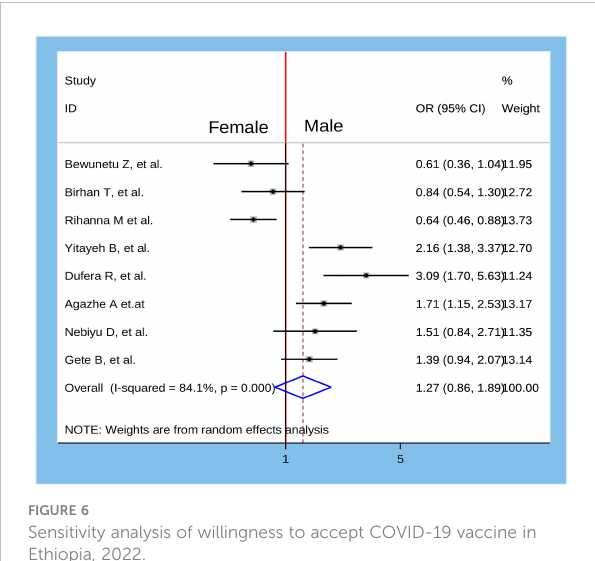
FIGURE 7 Association between sex and willingness to accept COVID-19 vaccine in Ethiopia,